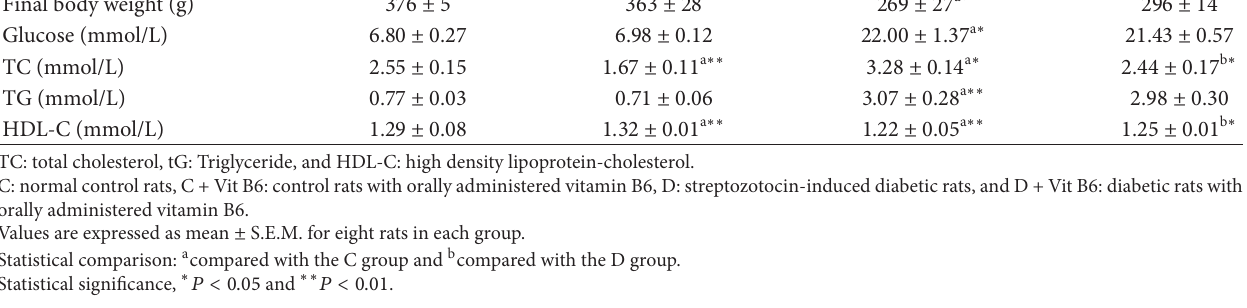
Table 2: Antioxidative enzyme activities and serum vitamin B6 levels in control and experimental groups of rats. Group C C + Vit B6 D D + Vit B6 Paraoxonase activity (U/L) Arylesterase activity (kU/L) SOD (U/mL) Vitamin B6 ( 𝜇